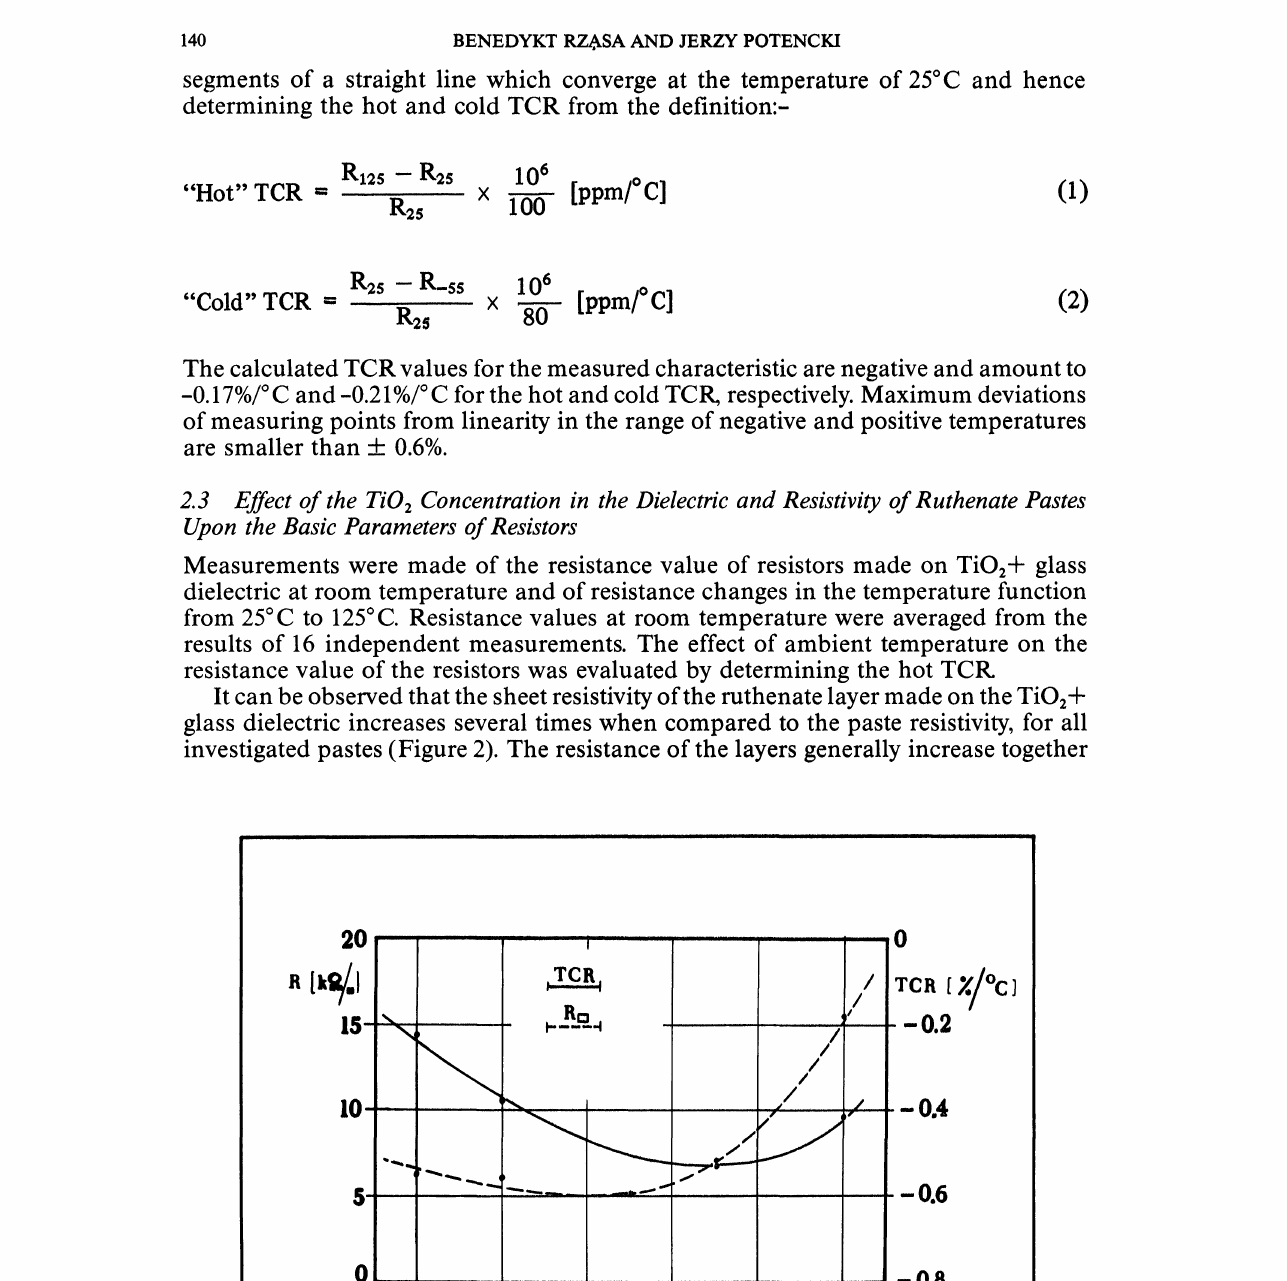
FIGURE3 Effect ofresistorpeakfiringtemperatureon resistance value and TCR. Resistors madeofl kfl/E] paste on dielectric 70% TiO + 30%